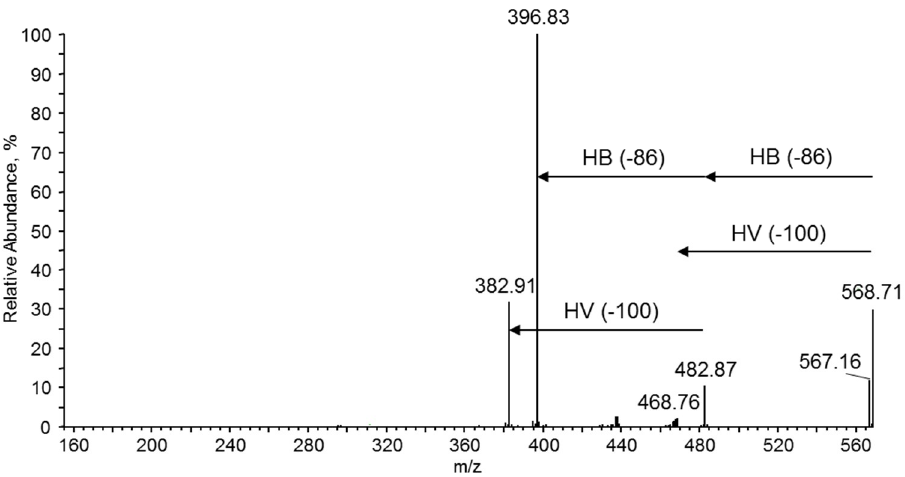
Figure 12. ESI-MS/MS spectrum acquired for the selected potassium adduct of oligomers at m/z 583. Scheme 2 presents the proposed fragmentation paths for the parent ion of m/z 583 shown in Figure 12. Scheme 2. Proposed fragmentation paths of the parent ion m/z 583 observed in the ESI-MS/MS spectrum.